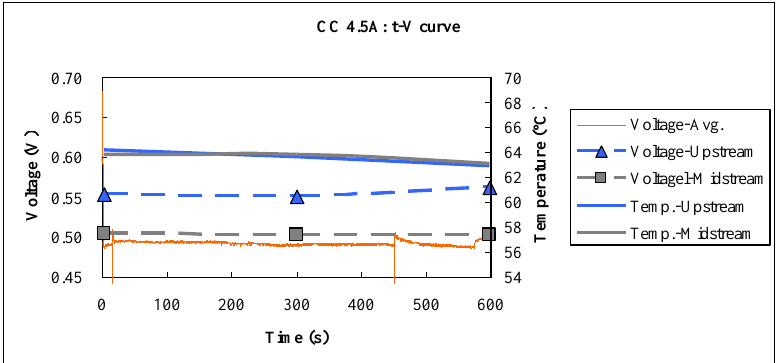
Figure 13. Voltage and temperature difference at 4.5 A constant current. CC 4.5A: t-V curve